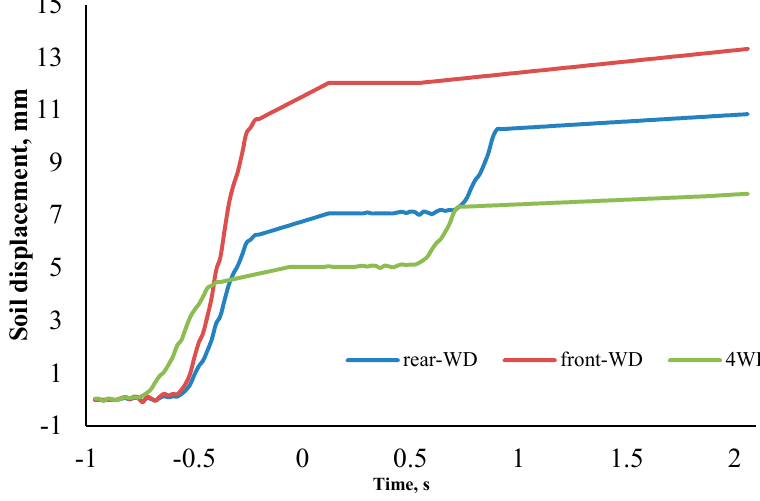
Figure 11. Soil strain along the lateral (y) direction.